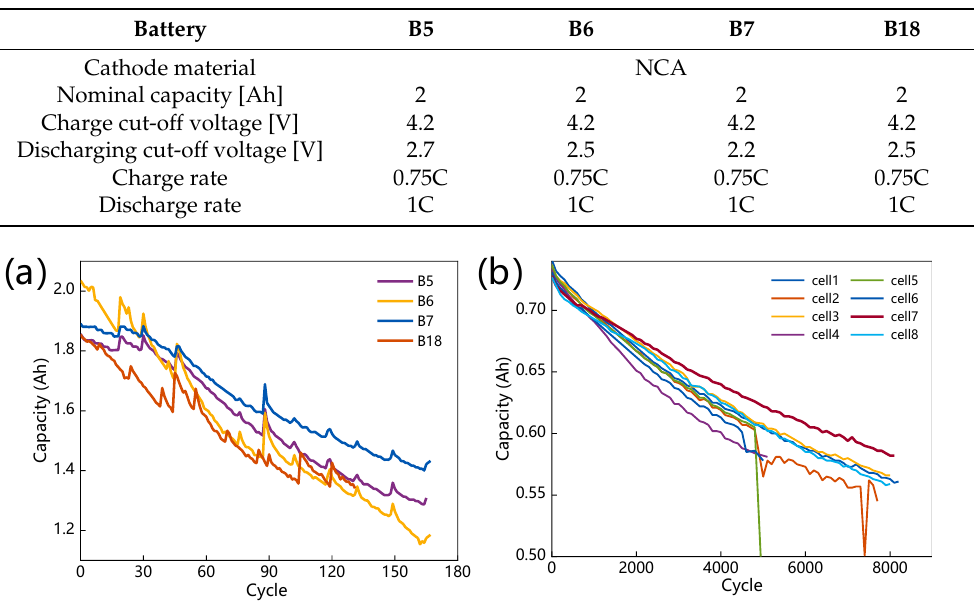
Table 1. Specific cycle condition of the NASA dataset.